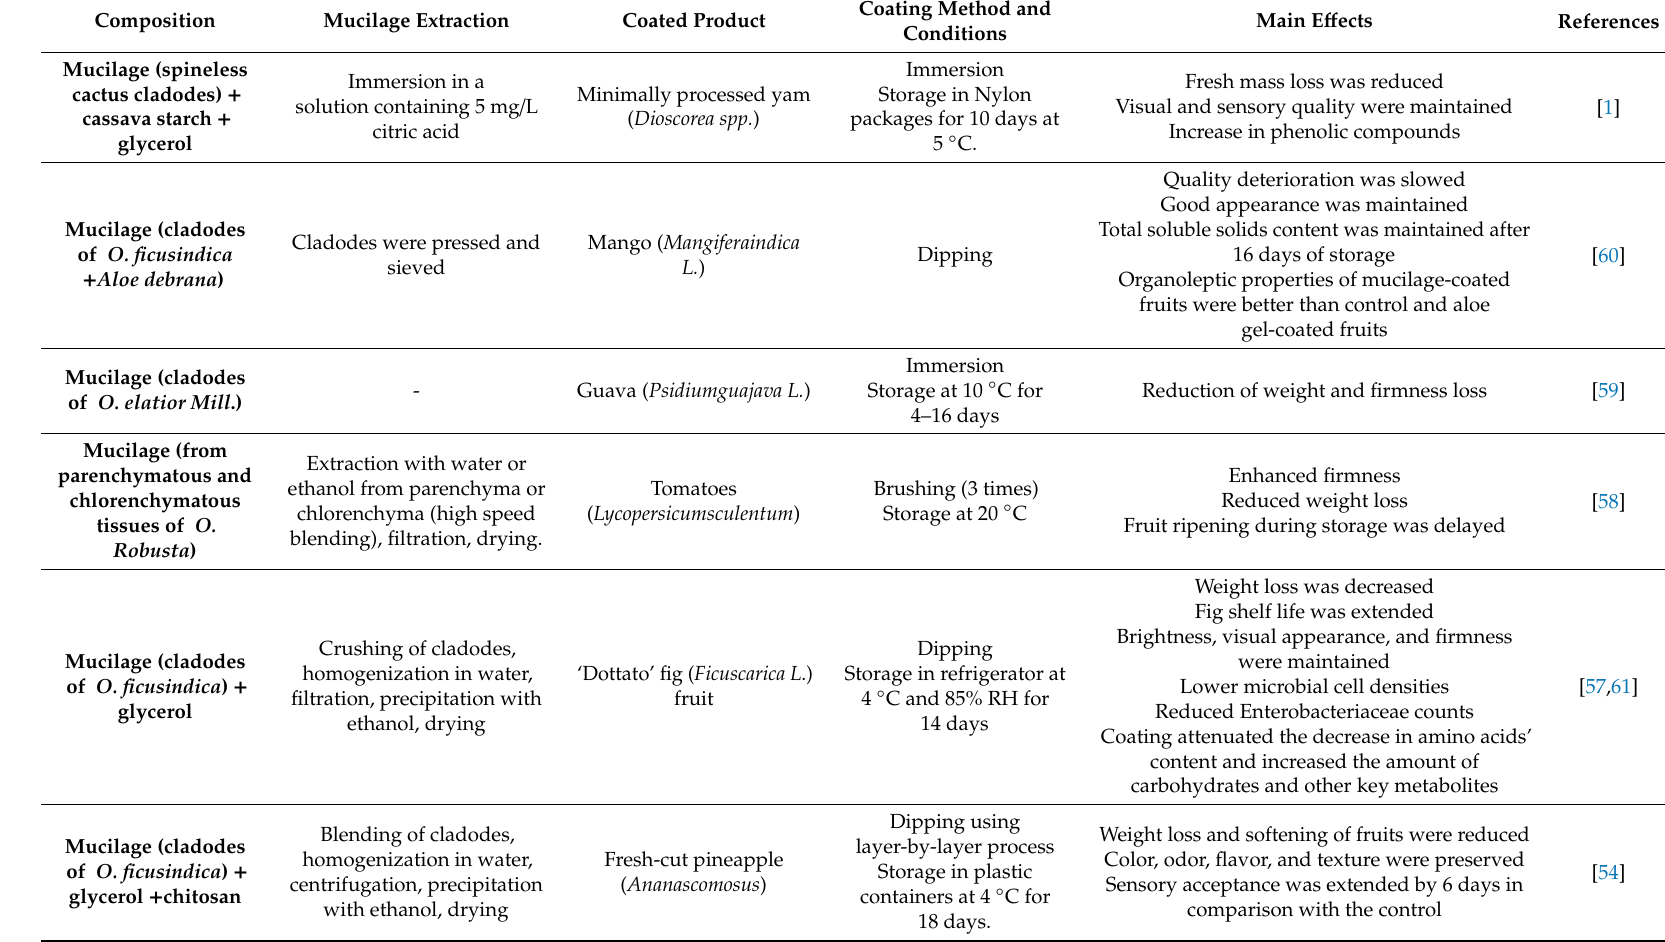
Table 3. Coatings based on cactus